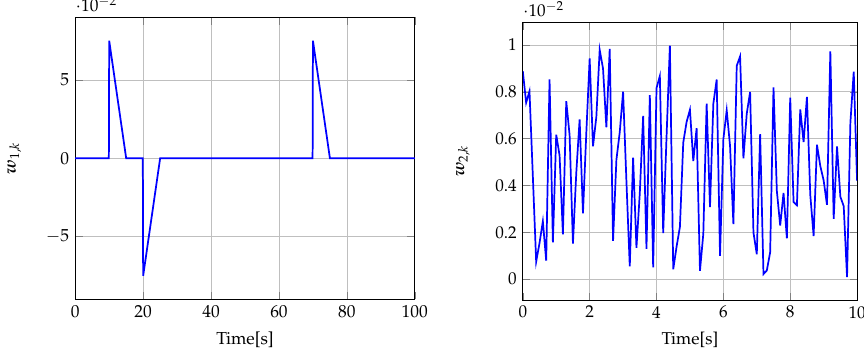
Figure 2. Disturbance signal w 1, k ( left ) (for t = 0, . . . ,100) and measurement noise signal w 2, k ( right ) (for t = 0, . . .